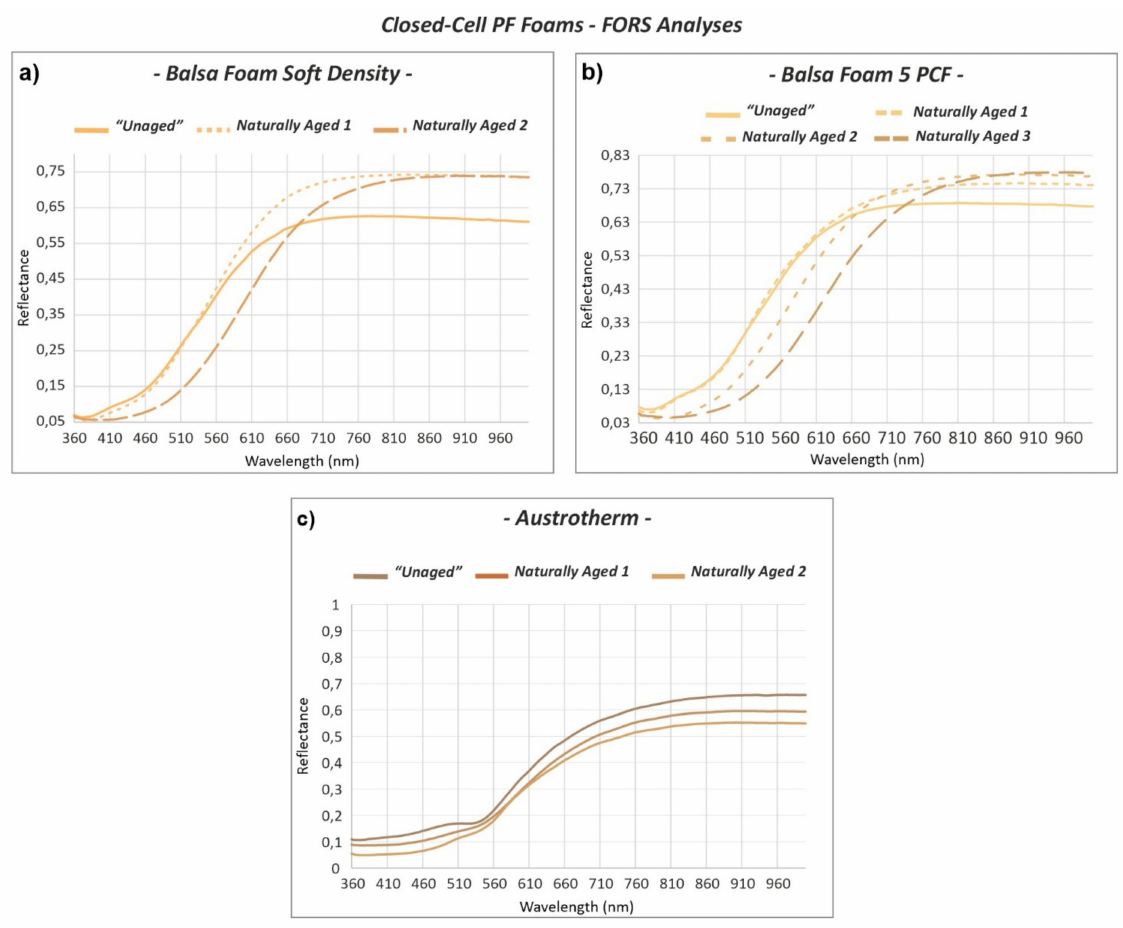
Figure 8. FORS reflectance spectra of the “Unaged” and Naturally Aged ( a ) Balsa foam soft density, ( b ) Balsa foam 5 PCF, and ( c ) Austrotherm closed-cell PF